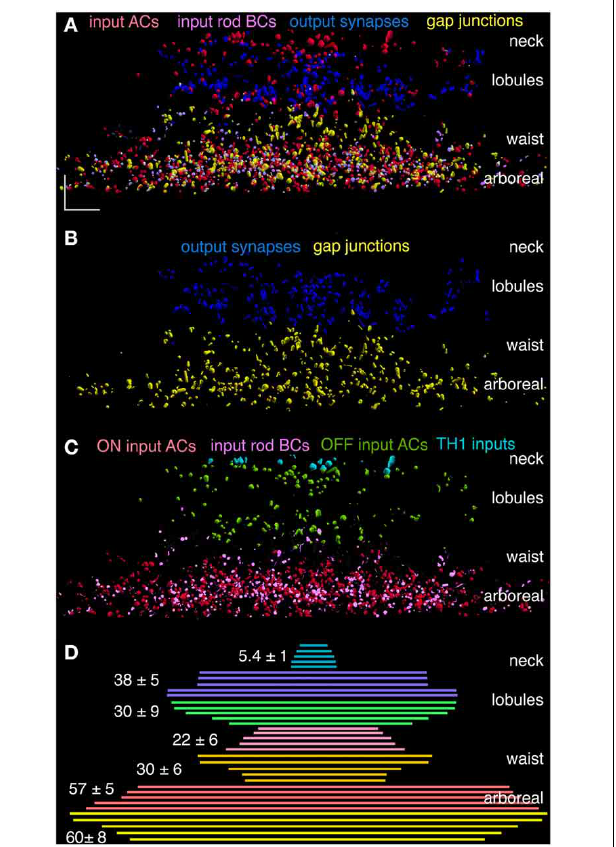
FIGURE 11 | Combined partner distributions for AII cells 410, 476, 514, 2610, and 3679. (A) Superimposed AC synaptic input (red), rod BC ribbon input (magenta), coupling (yellow) and synaptic output (blue) mapped onto its surface with stratified anatomical features. (B) Outputs and coupling are completely segregated. (C) Inputs can be parsed into TH1 cell ON (cyan), OFF inhibition (green) and ON excitation (magenta) and ON inhibition (red). OFF excitation is so minimal that it is not visible in the plots. (D) The lateral extents of key stratified zones for each cell are centered and superimposed with the mean ± 1 SD width at left. The larger spread for the neck in C is caused by the misalignment of cell bodies with the center of the dendritic arbor. XY Scale, 10 μ